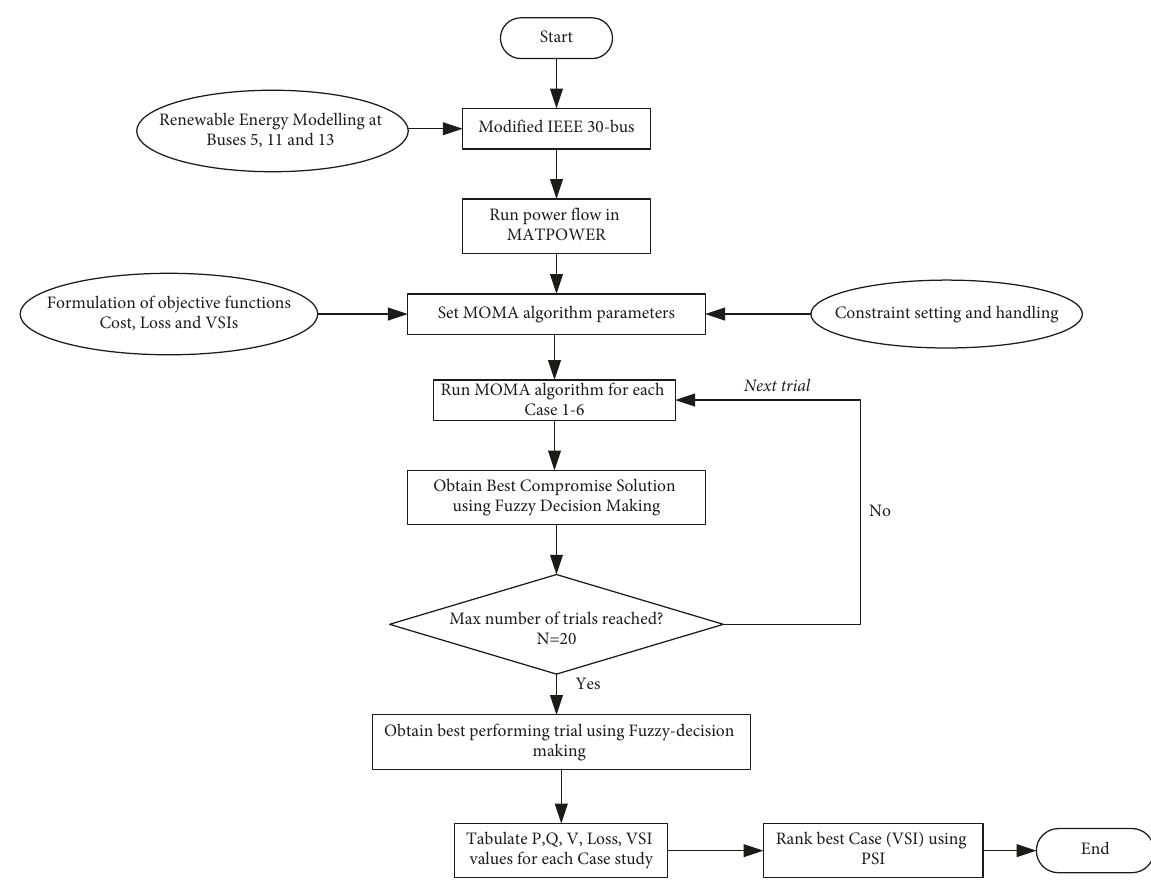
Figure 2: Methodology flow process